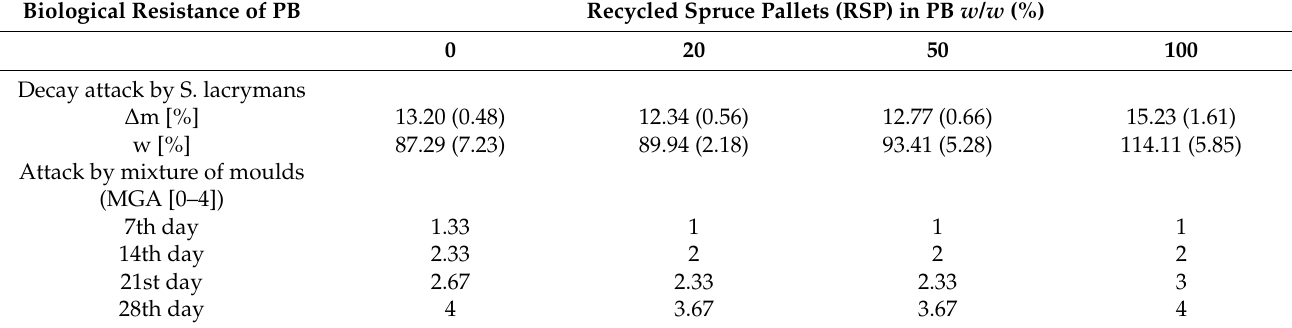
Table 4. Biological resistance of the reference/control PB (PB-C) and the PBs containing particles from recycled spruce pallets (PB-RSP): (I) decay resistance valued on the basis of mass loss ( ∆ m) caused by S. lacrymans ; (II) mould resistance to against a mixture of microscopic fungi valued on the basis of mould growth activity (MGA) on the top surface of PBs (MGA from 0 to 4).